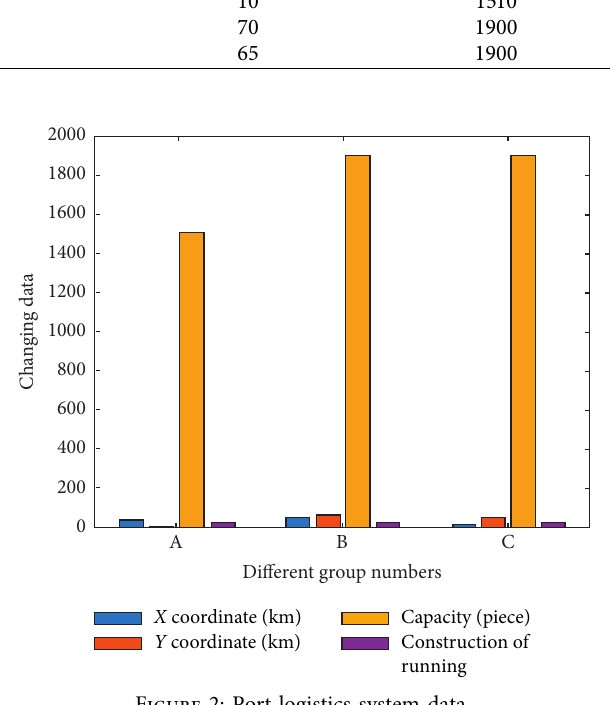
Figure 2: Port logistics system data. Table 2: Data of emergency supplies demand